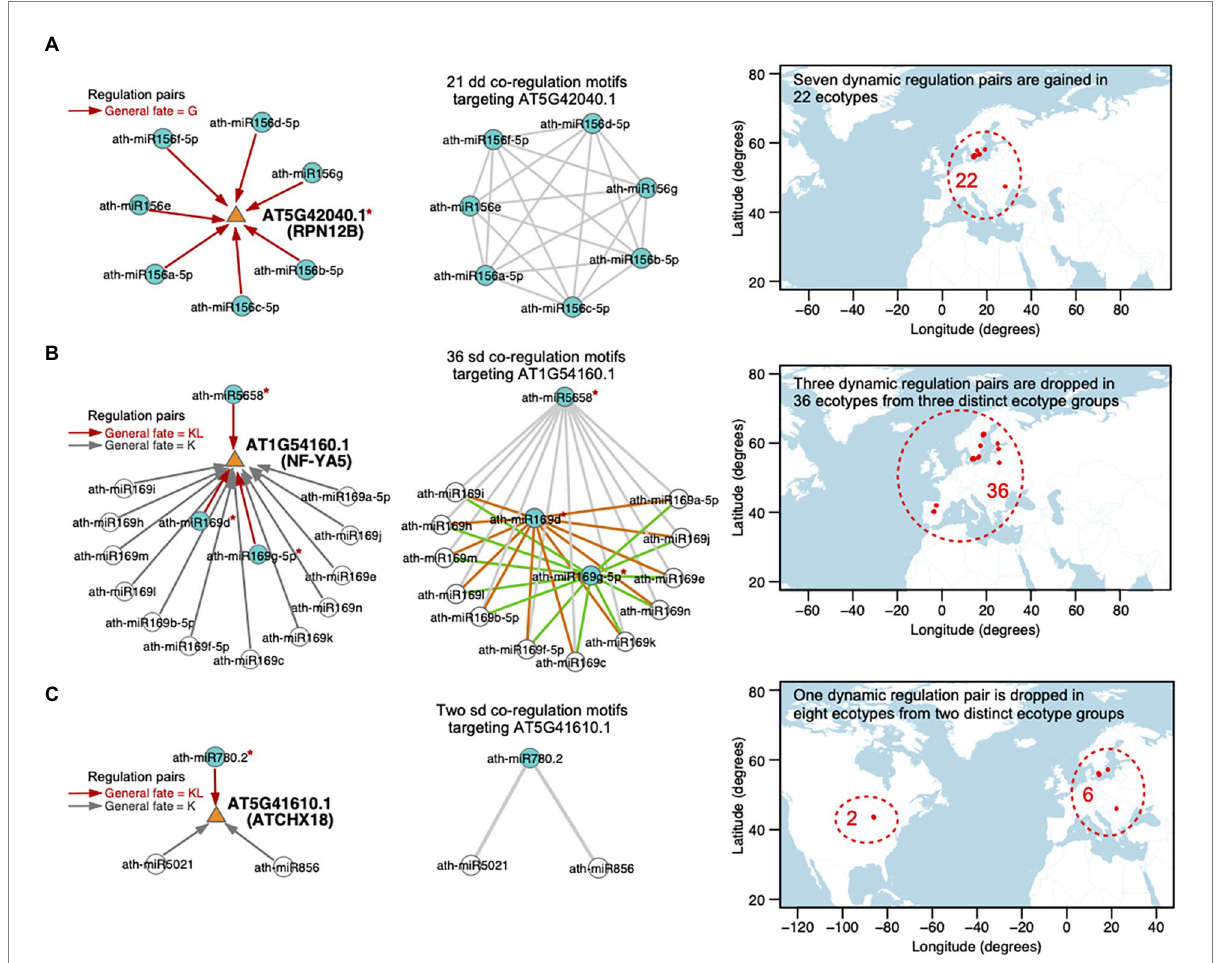
FIGURE 7 Case studies for the dynamic miRNA regulations toward the targets, that are gained or dropped in specific ecotypes. Three transcripts are shown as examples, which are (A) AT5G42040.1 (RPN12B), (B) AT1G54160 (NF-YA5), and (C) AT5G41610.1 (ATCHX18). (Left panel) miRNA–target regulations. The targeted transcript is depicted with an orange triangle and the miRNA is depicted with a circle. Directed edges represent miRNA– target regulations, including dynamic regulations (the general fate = G or KL, red edge) and static regulations (the general fate = K, gray edge). A blue circle indicates that the corresponding miRNA dynamically regulates the target, while a white circle represents a static regulation toward the target. The red symbol * beside a miRNA or a target denotes the reprogramming of the regulation attributed by the SNP(s) in the sequence. (Middle panel) Cooperative miRNA pairs co-regulating a transcript, defined as miRNA–miRNA–target co-regulation motifs. A circle node represents miRNA and an edge represents a crosstalk between two miRNAs. There are 21 dd-type, 36 sd-type, and 2 sd-type co-regulation motifs targeting (A) AT5G42040.1, (B) AT1G54160.1, and (C) AT5G41610.1, respectively. dd-type co-regulation motifs toward AT5G42040.1 are newly gained in the same 22 ecotypes, which is related to an SNP in the target (A) . In contrast, sd-type co-regulation motifs are disrupted in non-overlap ecotype groups because of the SNPs in (B) different miRNAs sequences or (C) different SNPs in the same miRNA sequence. (Right Panel) Map showing the locations (longitude on x-axis and latitude on y-axis) from which the ecotypes employed in each case study originate. The region harboring the ecotypes (red dots) is included in a red dashed circle with the number of ecotypes labeled. For each ecotype group, the standard deviation values and adjusted empirical p -values of seven bioclimatic variables are listed in Supplementary Table